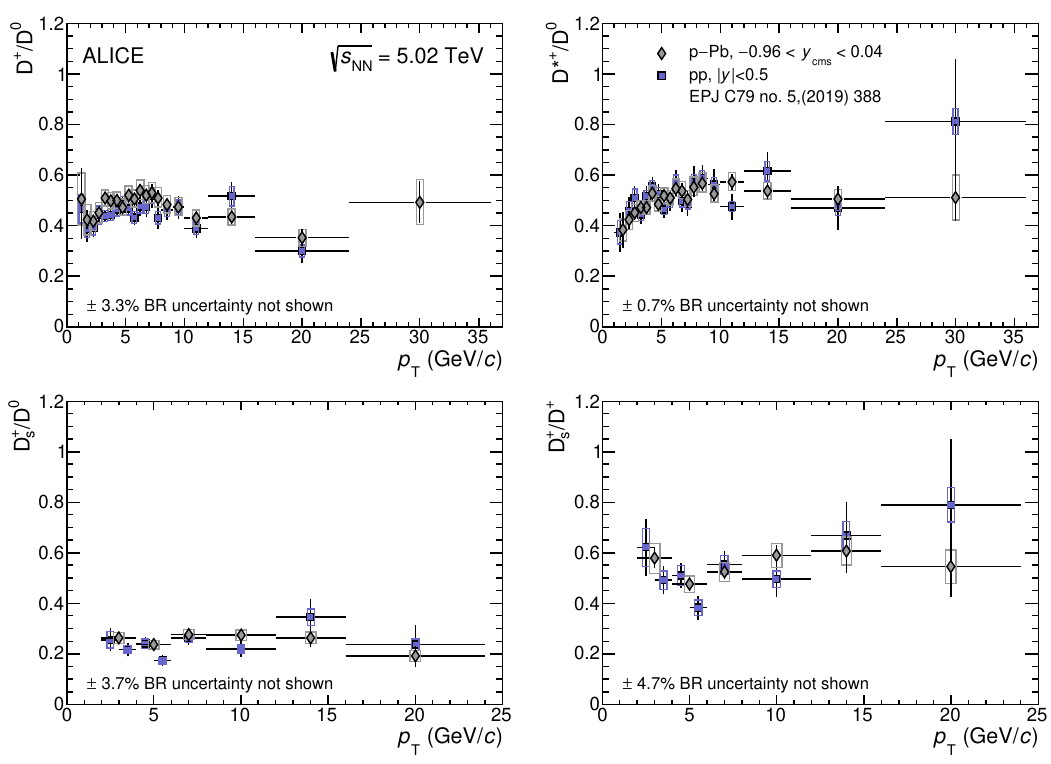
Figure 13 . Ratios of prompt D-meson production cross sections as a function of p T in p{Pb p collisions at s = 5 : 02 TeV. The results are compared with those of pp collisions at the same NN centre-of-mass energy [70]. The vertical bars and the empty boxes represent the statistical and systematic